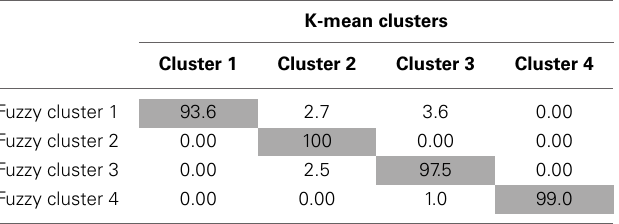
Table 5 | Percentage of fuzzy cluster solutions that belong to corresponding k-means clustering solutions with a membership exponent of